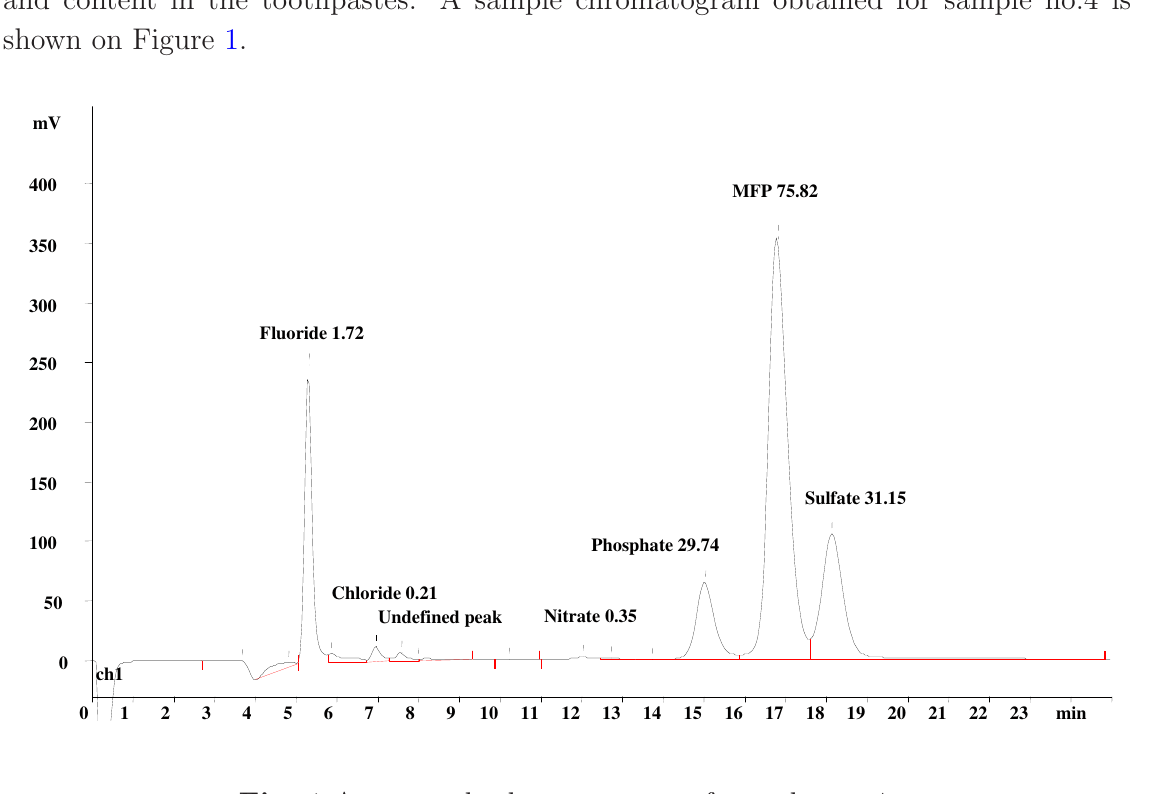
Fig. 1 An example chromatogram of sample no.